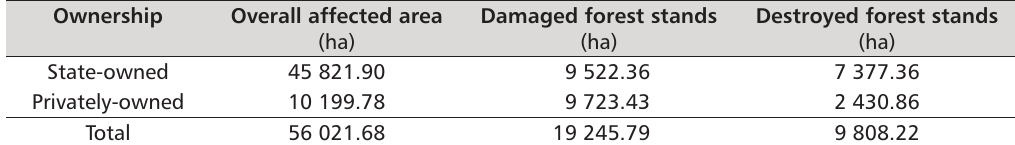
TABLE 1. Forest area affected by natural hazards (FA Delnice, FA Senj, FA